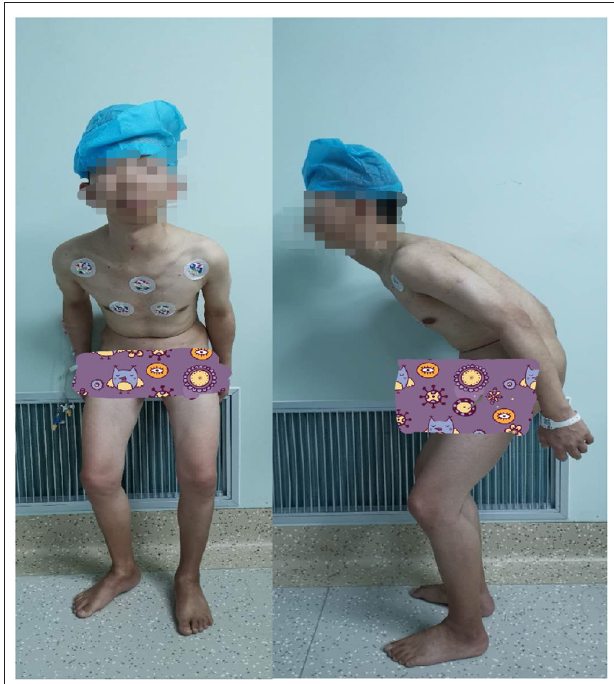
FIGURE 1 | Front and side views of the